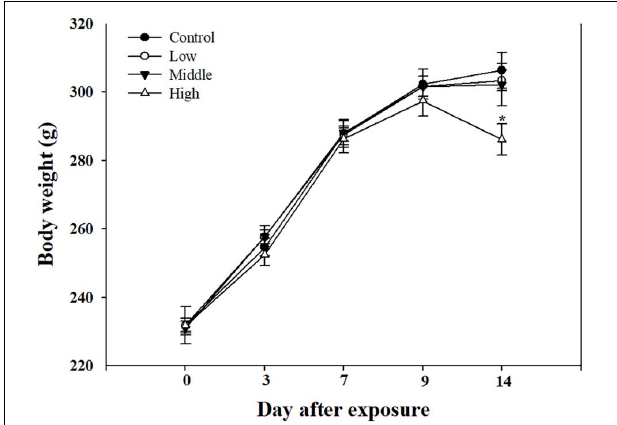
FIGURE 3 | The body weight changes in rats exposed to sub-acute SM. Male rats inhaled aerosolic SM for 2 weeks. The values are reported as the mean ± SE (Student’s t -test, ∗ P < 0.05 vs. control).